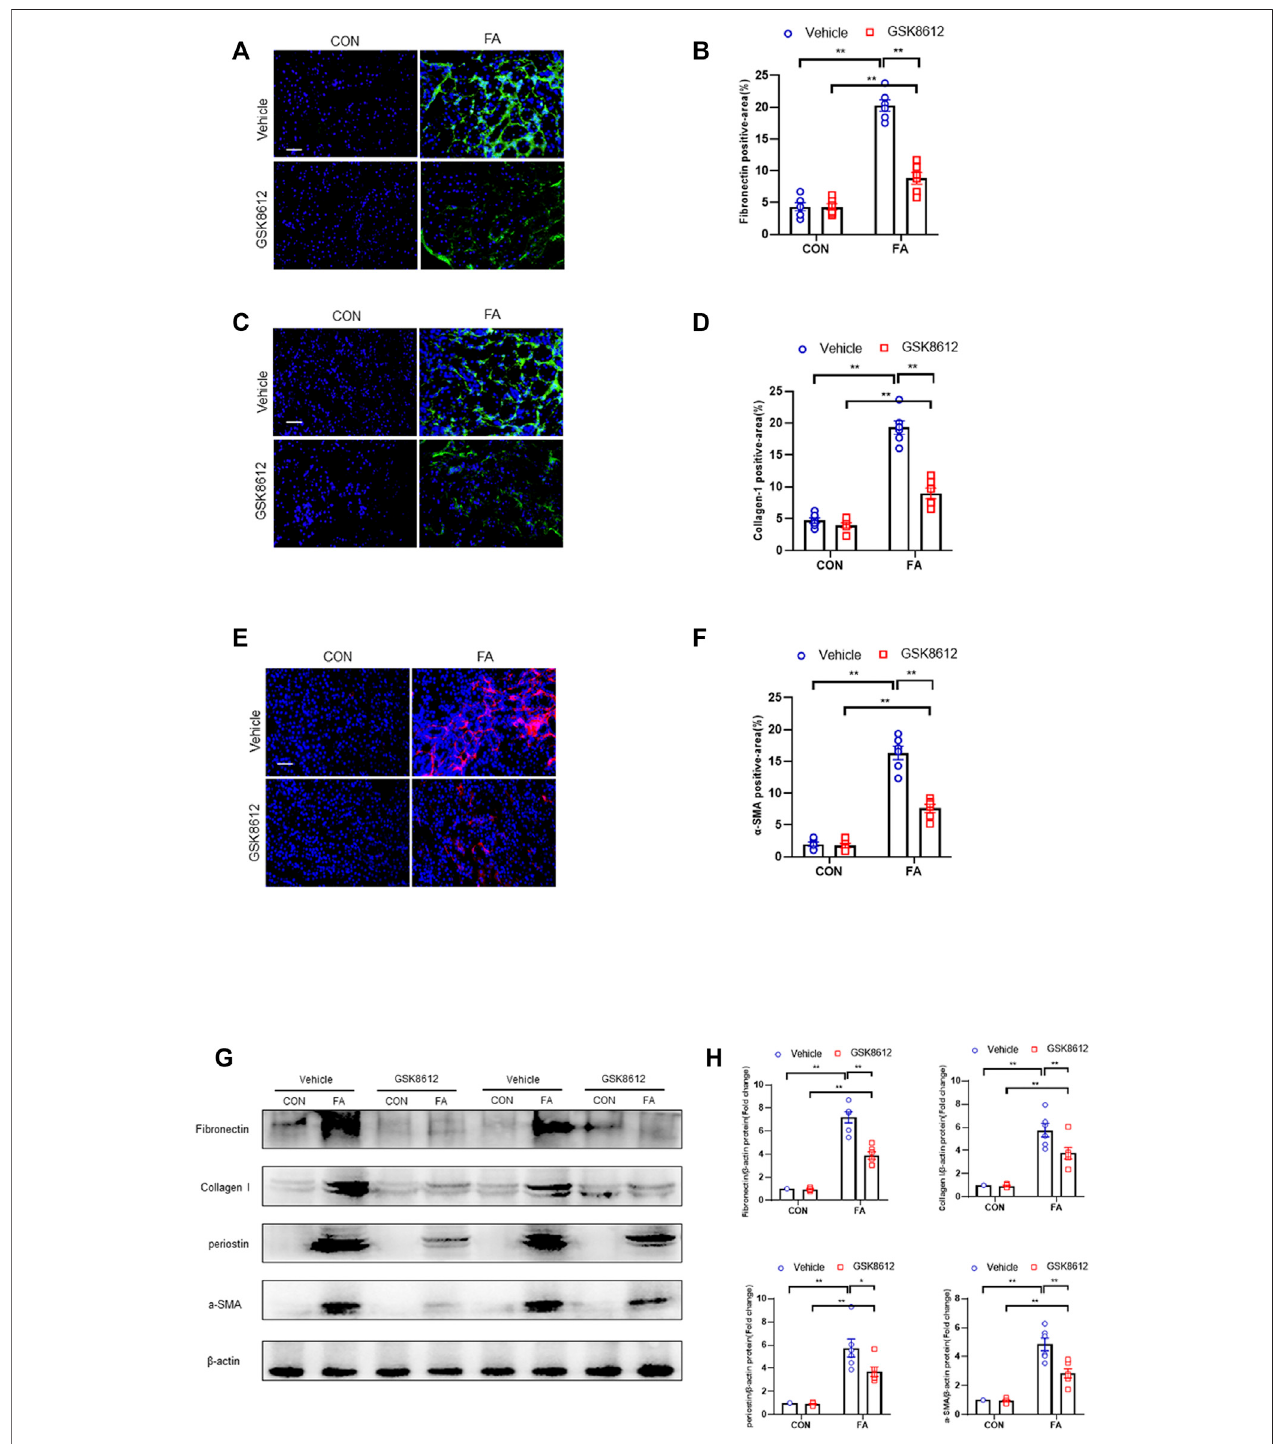
FIGURE 8 | Pharmacological inhibition of TBK1 reduces ECM proteins expression and fi broblasts activation in FA nephropathy. (A) Representative immuno fl uorescence photomicrographs of kidney sections in each group stained for fi bronectin (green) and DAPI (blue). (B) Quantitative analysis of fi bronectin-positive area in the kidneys. (C) Representative photomicrographs of kidney sections in each group stained for collagen I (green) and DAPI (blue). (D) Quantitative analysis of collagen I-positive area in the kidneys. (E) Representative immuno fl uorescence photomicrographs of kidney sections in each group stained for α -SMA (red) and DAPI (blue). (F) Quantitative analysis of α -SMA-positive area in the kidneys. (G) Representative western blots show the levels of fi bronectin, collagen I, periostin, and α -SMAprotein expression in each group. (H) Quantitative analysisof fi bronectin,collagenI, periostin, and α -SMA protein expression levels inthe kidneys. ** p < 0.01, * p < 0.05; n = 6 in each group; Scale bar: 50 μ